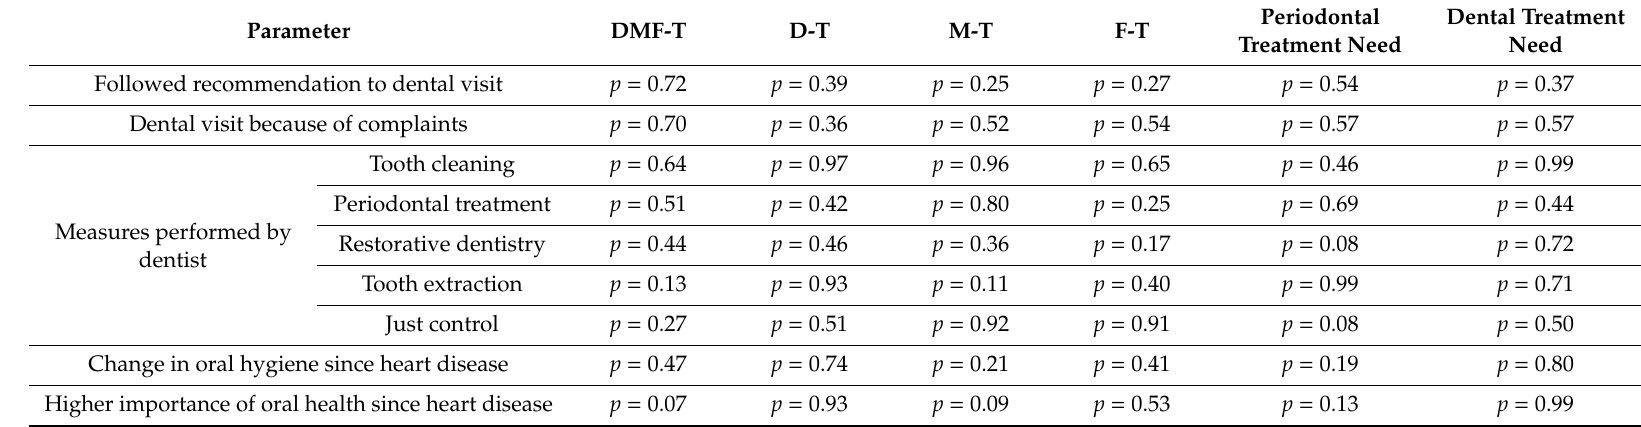
Table 6. Association between questionnaire and oral health in the total cohort after 12 months, significance level: p <